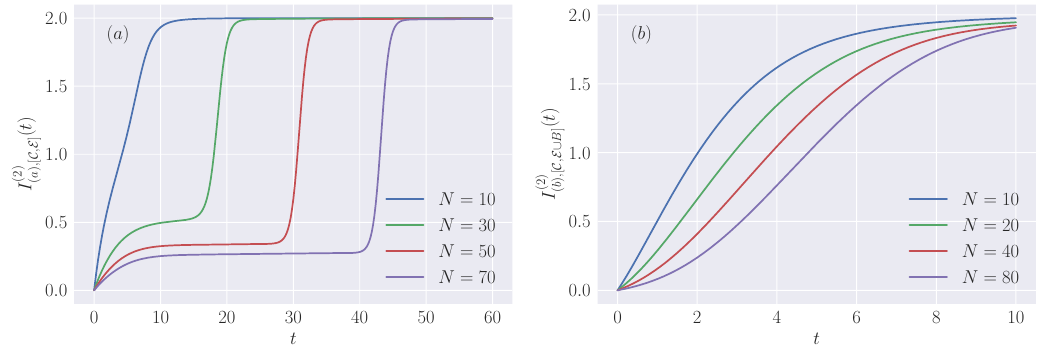
Figure 10 . Same plots as in (cid:12)gure 9. The evolution is now driven by the RUC with a conserved U(1) charge de(cid:12)ned in section 3.2, where we set (cid:21) 1 = 1, (cid:21) 2 = 2 (and d =